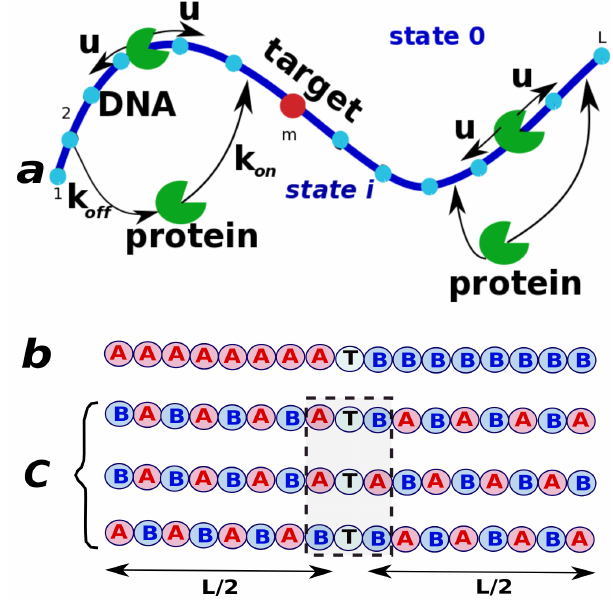
Figure 7. A simplified view on the protein search on DNA with two different types of subunits, A and B . ( a ) A general scheme; ( b ) DNA is viewed as a symmetric block copolymer with the target in the middle of the chain; ( c ) DNA is viewed as alternating copolymer with different compositions of the subunits flanking the target in the middle of the chain. Adapted with permission from Ref. [20].